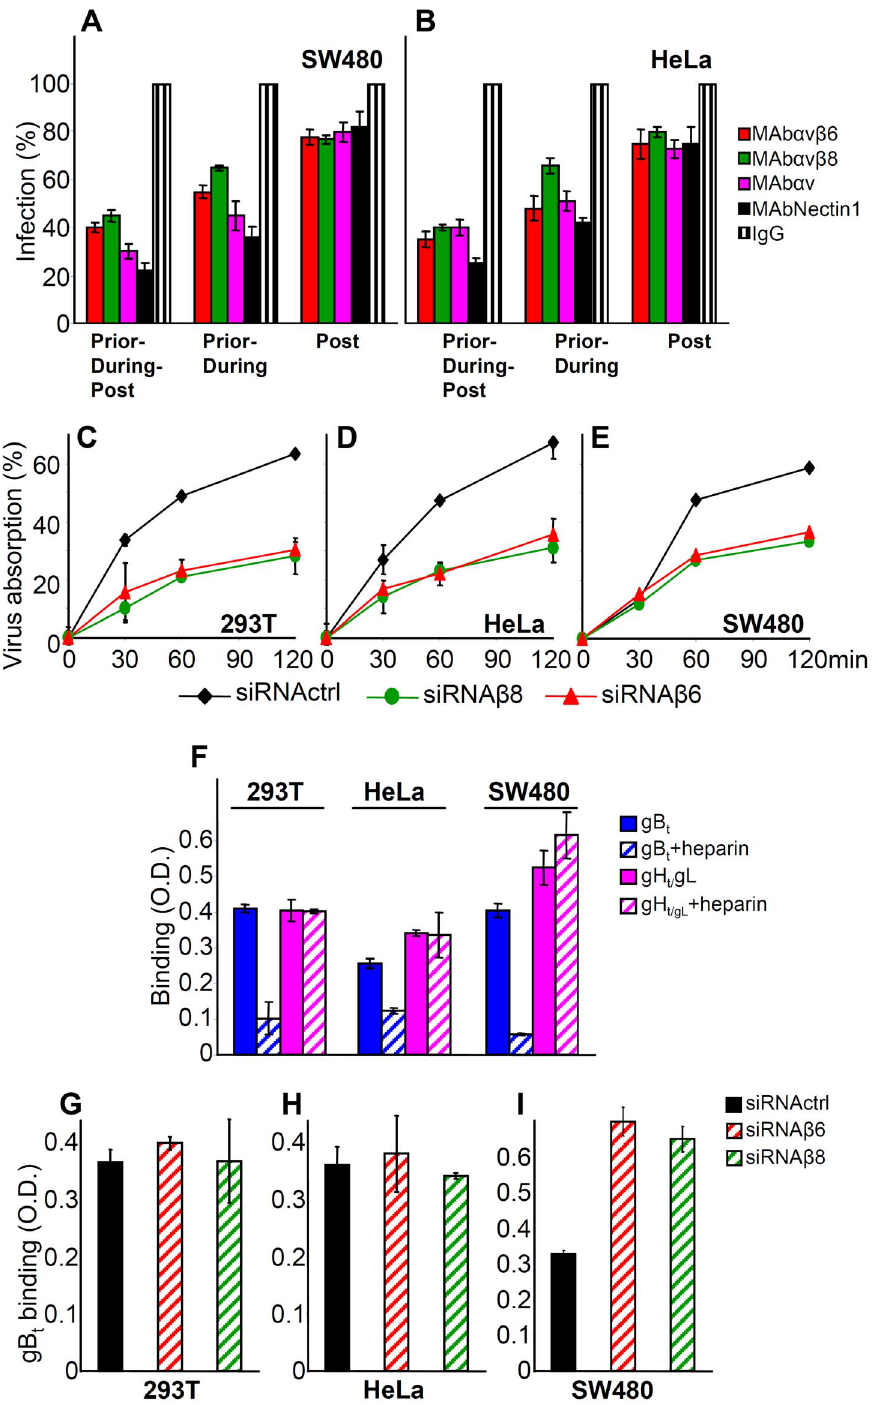
Figure 6. Steps in HSV infection inhibited by function-blocking MAbs to a v b 6- and a v b 8–integrins, or by integrin silencing. (A, B) The indicated cells were exposed to MAb 2077Z to a v b 6-integrin, MAb 37E1 to a v b 8–integrin, MAb L230 to a v–integrin, MAb R1.302 to nectin1, or control IgGs. In the ‘‘Prior-during-post’’ treatment cells were exposed to the antibodies from 1 h prior to infection till time of harvest, at 6–8 h after infection. In the ‘‘Prior-during’’ treatment cells were exposed to the antibodies from 1 h prior to infection and during virus absorption. In the ‘‘Post’’ treatment, cells were exposed to the antibodies from the end of virus absorption till harvesting. Cells were infected with R8102 (3 pfu/cell). Infection was quantified in triplicates as detailed in the legend to Fig. 3, and expressed as percentage relative to cells treated with control IgGs. (C–E) Inhibition of R8102 absorption to integrin-silenced cells. b 6- or b 8–integrins were silenced by siRNAs. Control cells received siRNA control. Cells silenced for 2–3 days were infected with R8102 for 120 min at 4 u C. Aliquots of the viral inoculum were withdrawn in duplicates at the indicated times, and immediately titrated in Vero cells. Extent of virus absorption is expressed as percentage of the amount of virus present in the inoculum at 0 time. Bars show SD. (F) The binding of gB t , and not that of gH t /gL, to cells is inhibited by heparin. One-StrEP tagged gB t , gH t /gL or GFP t (2 m M each), the latter as a negative control, were preincubated or not with heparin (5 m g/ml) for 1 h at 4 u C, and then added to cells grown in 96-well plates, for 1 h at 4 u C.